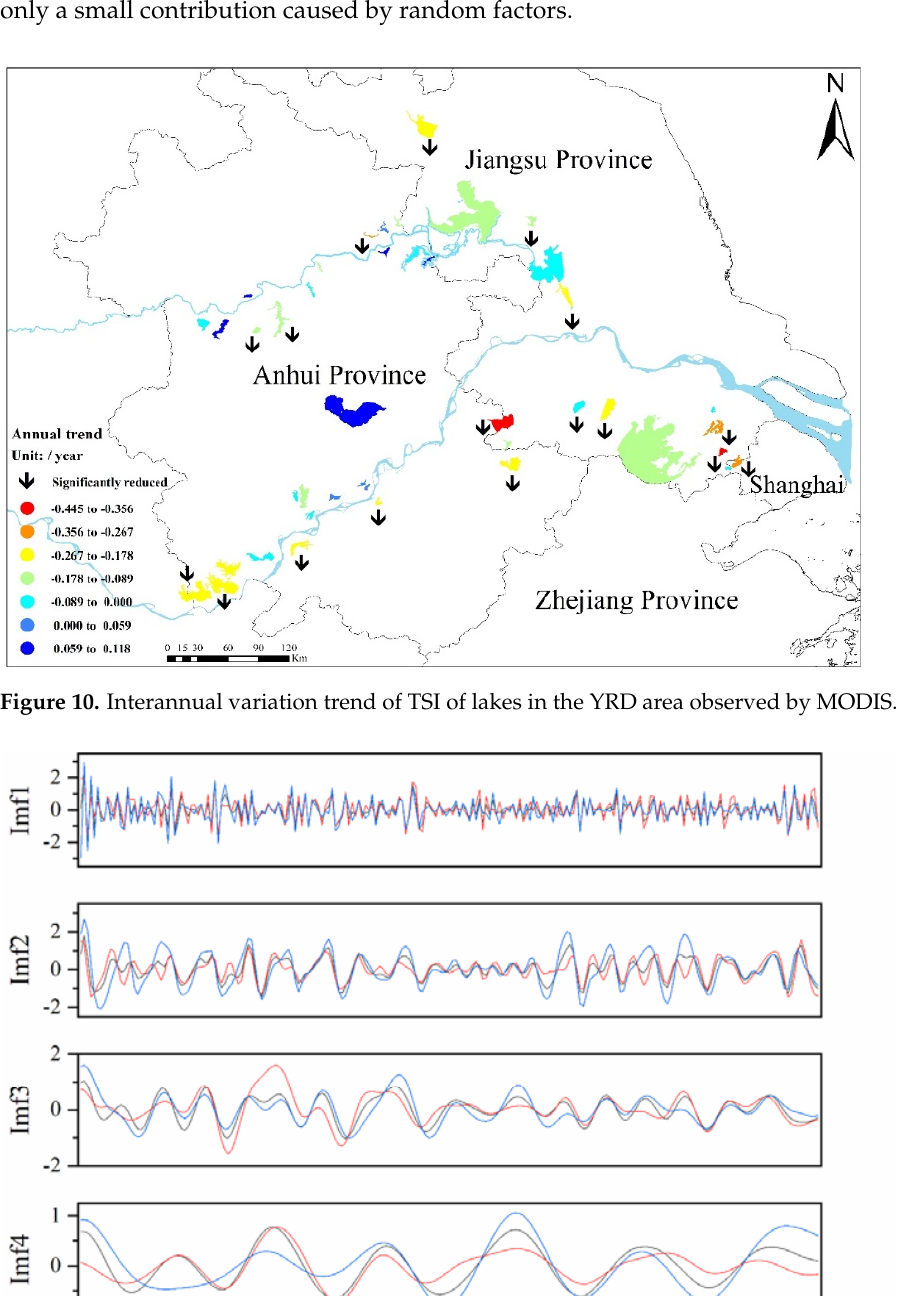
Figure 9. Annual and monthly changes in the TSI average from 2002 to 2020: ( a ) YRD, ( b ) LYR, and ( c ) LHR.